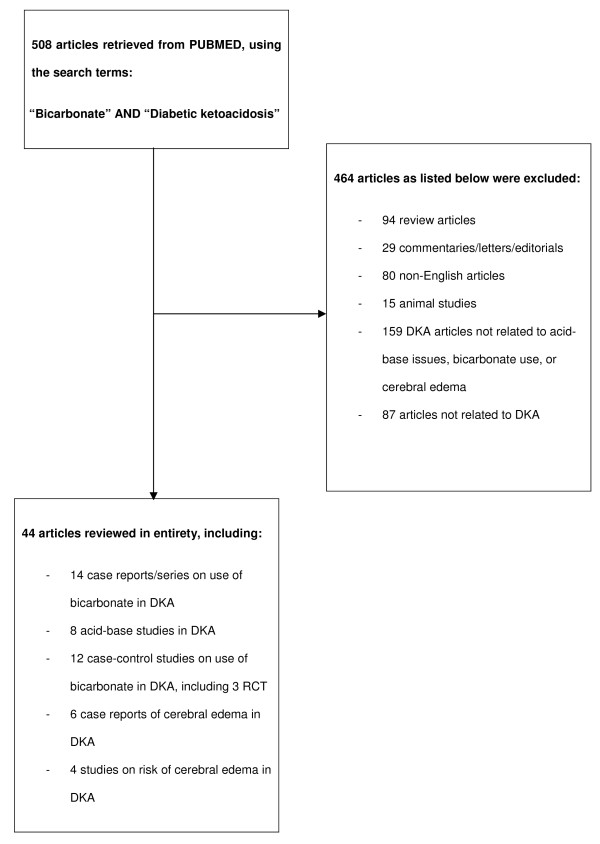
Overview of study selection process.